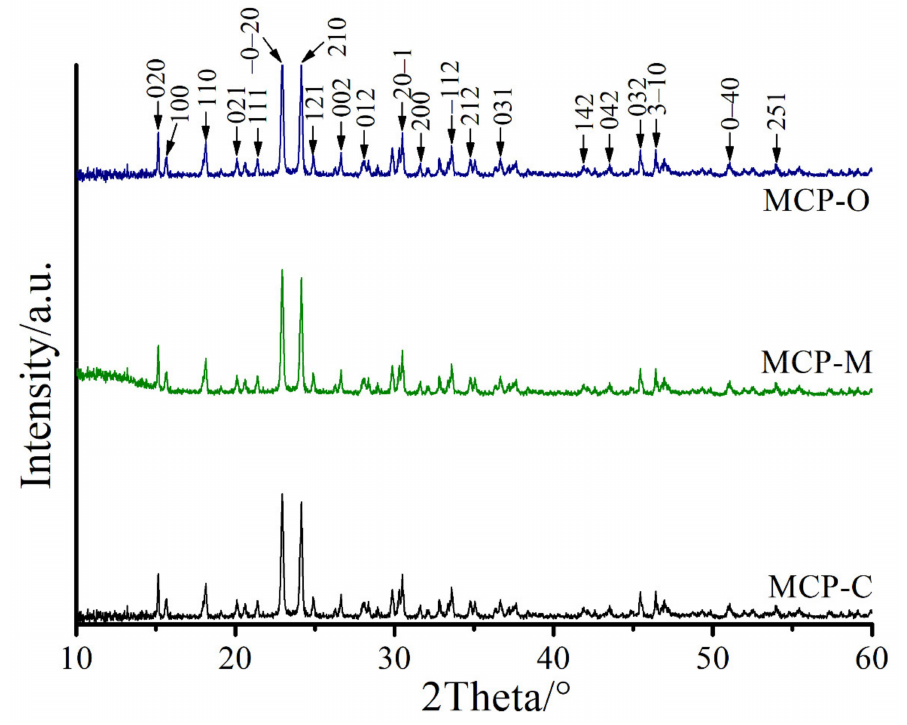
Figure 8. XRD patterns of MCP-C, MCP-M, and MCP-O samples.